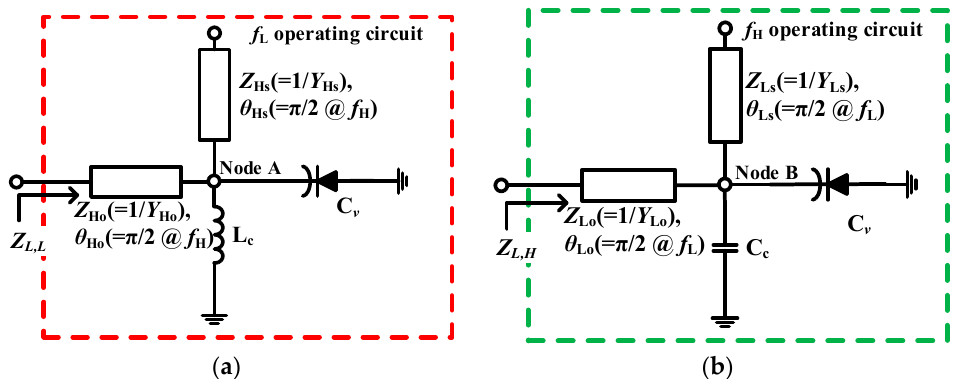
Figure 3. Each reflection load according to operating band: ( a ) Low-band operation; ( b ) High-band operation.